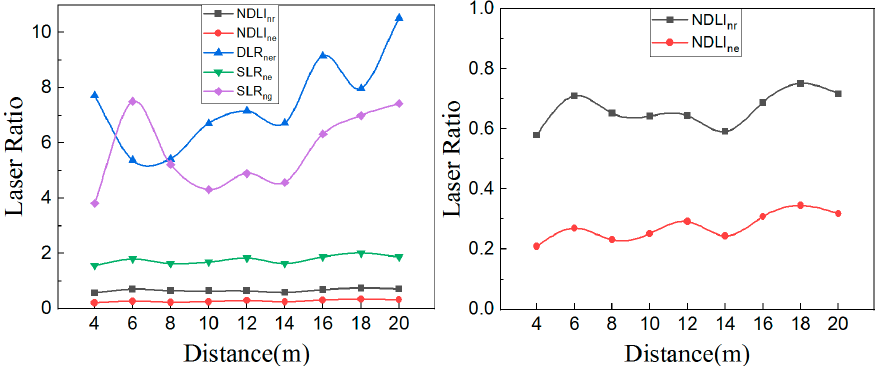
Figure 12. Laser ratio correction results for the leaf sample versus distance.